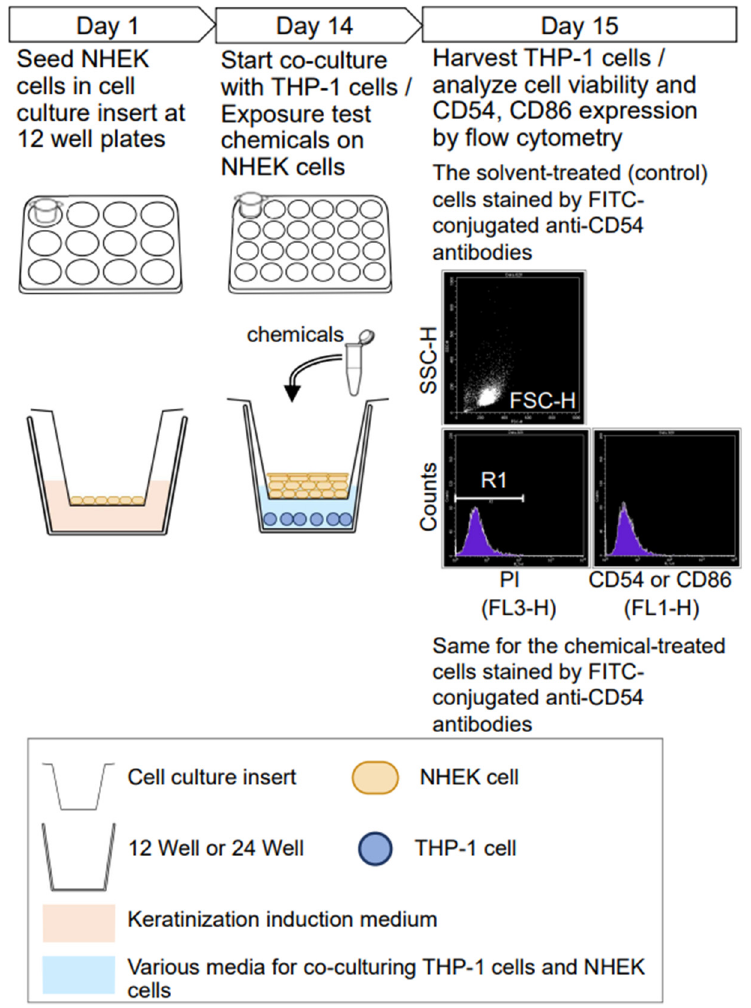
Figure 1. Schematic view of the workflow of the h-CLAT procedure in co-culture system. 2.1. Reagent 2,4-Dinitrochlorobenzene (DNCB, CAS 97-00-7, purity: ≥ 99%), lactic acid (LA, CAS